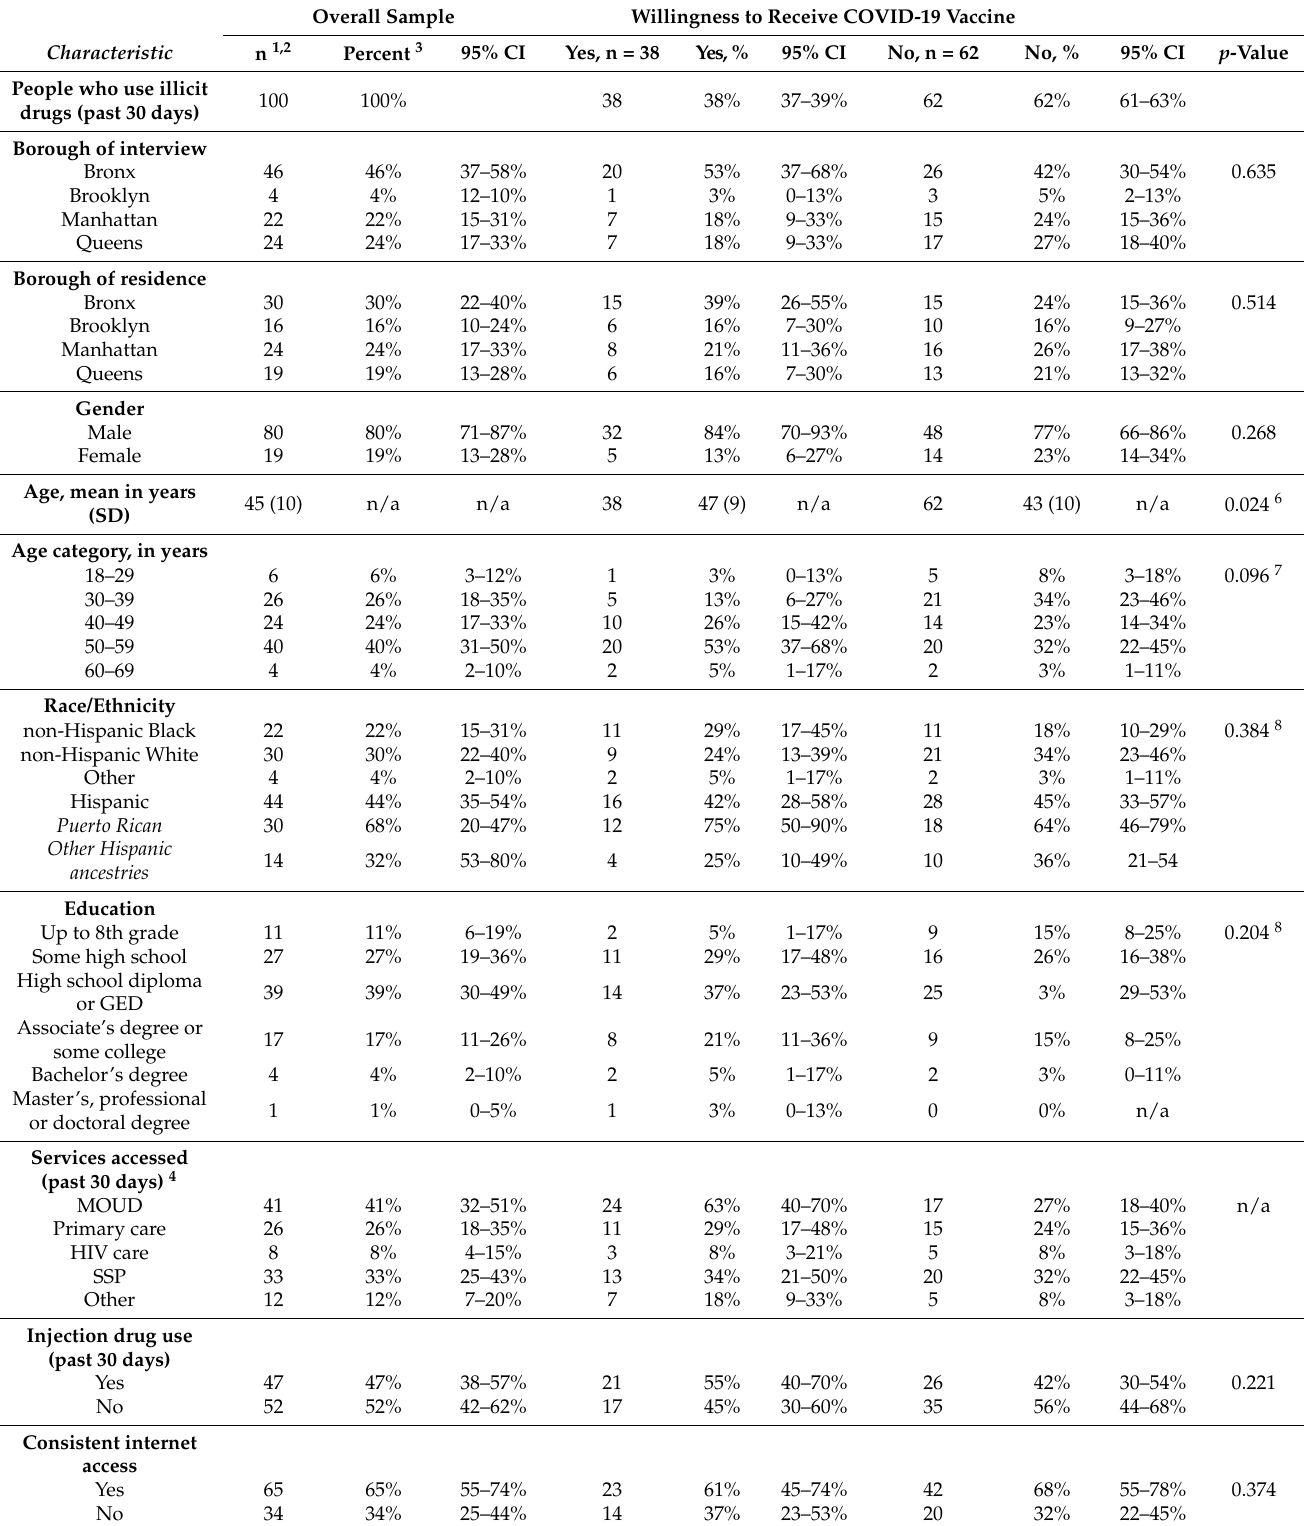
Table 1. Characteristics and associations with willingness to receive COVID-19 vaccine among people who use drugs in NYC,